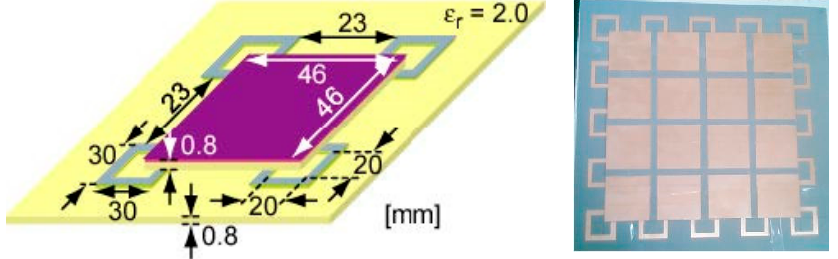
Figure 5. Transmission line for the dual-frequency band.